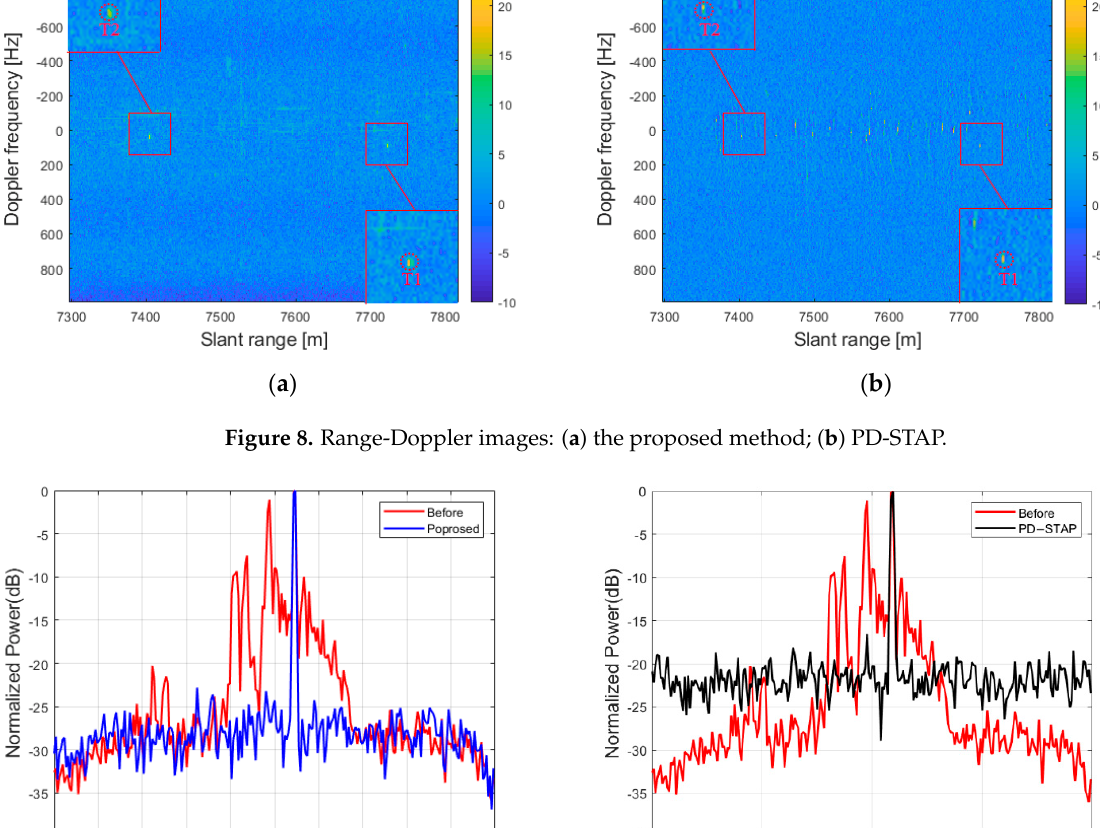
( b ) Figure 10. Output normalized SCNR of T2: ( a ) the proposed method; ( b ) PD − STAP. Figure 11a shows the range − Doppler image with superimposed moving target detec- tions by the amplitude detector. Many false detections are observable. Figure 11b shows the results of the phase detector assisted by the amplitude detector based on the CDP step. Fewer false detections are observable, which shows that the interferometric phase detector with the amplitude detector could significantly reduce the false detections. Multiple CPIs can be utilized to suppress radial scatterers. Figures 12 and 13 show the velocity estima- tion function out P